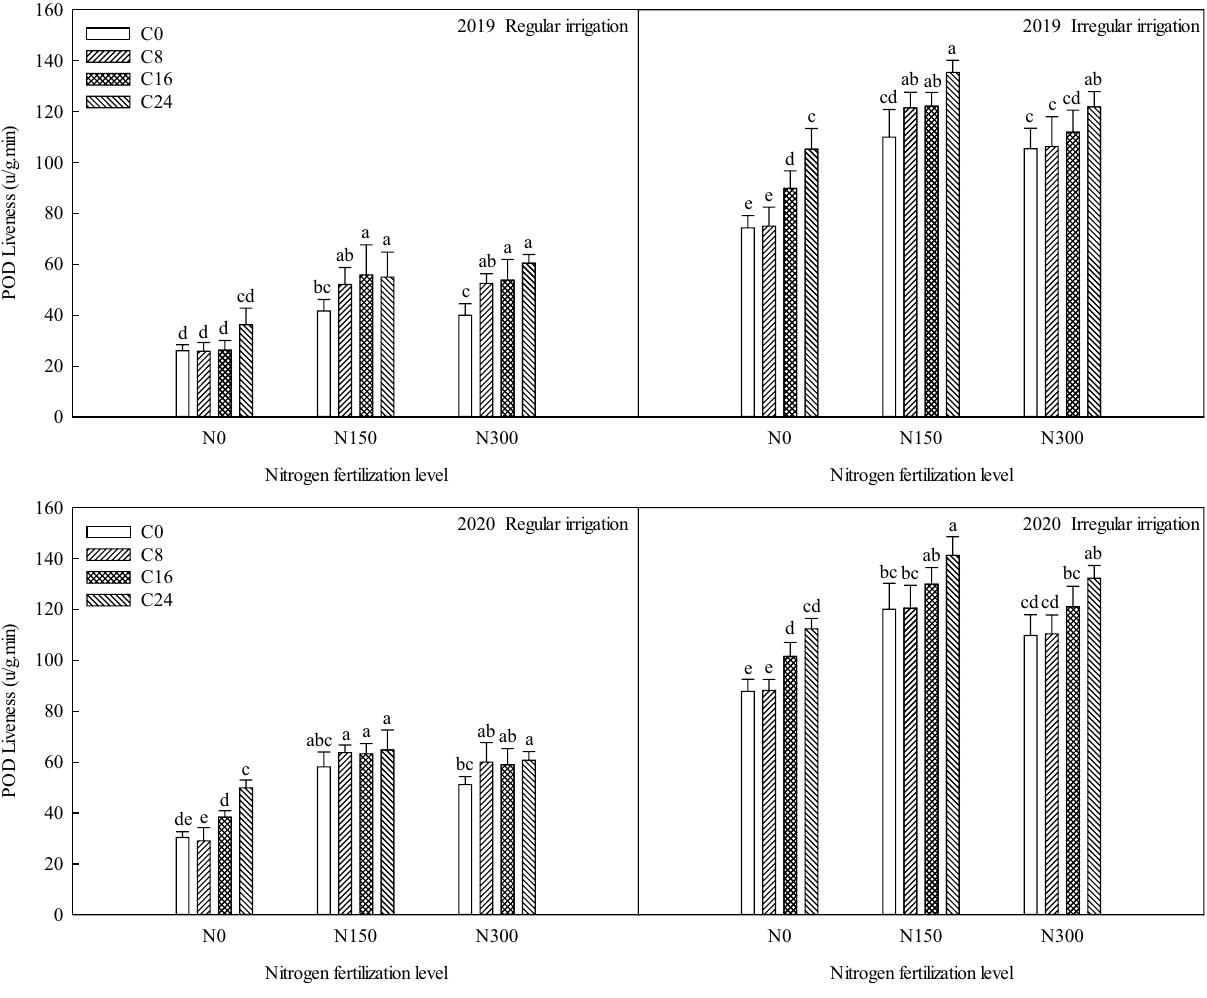
Figure 3. Effects of bio-char and nitrogen fertilizer on POD activity of maize under different irrigation